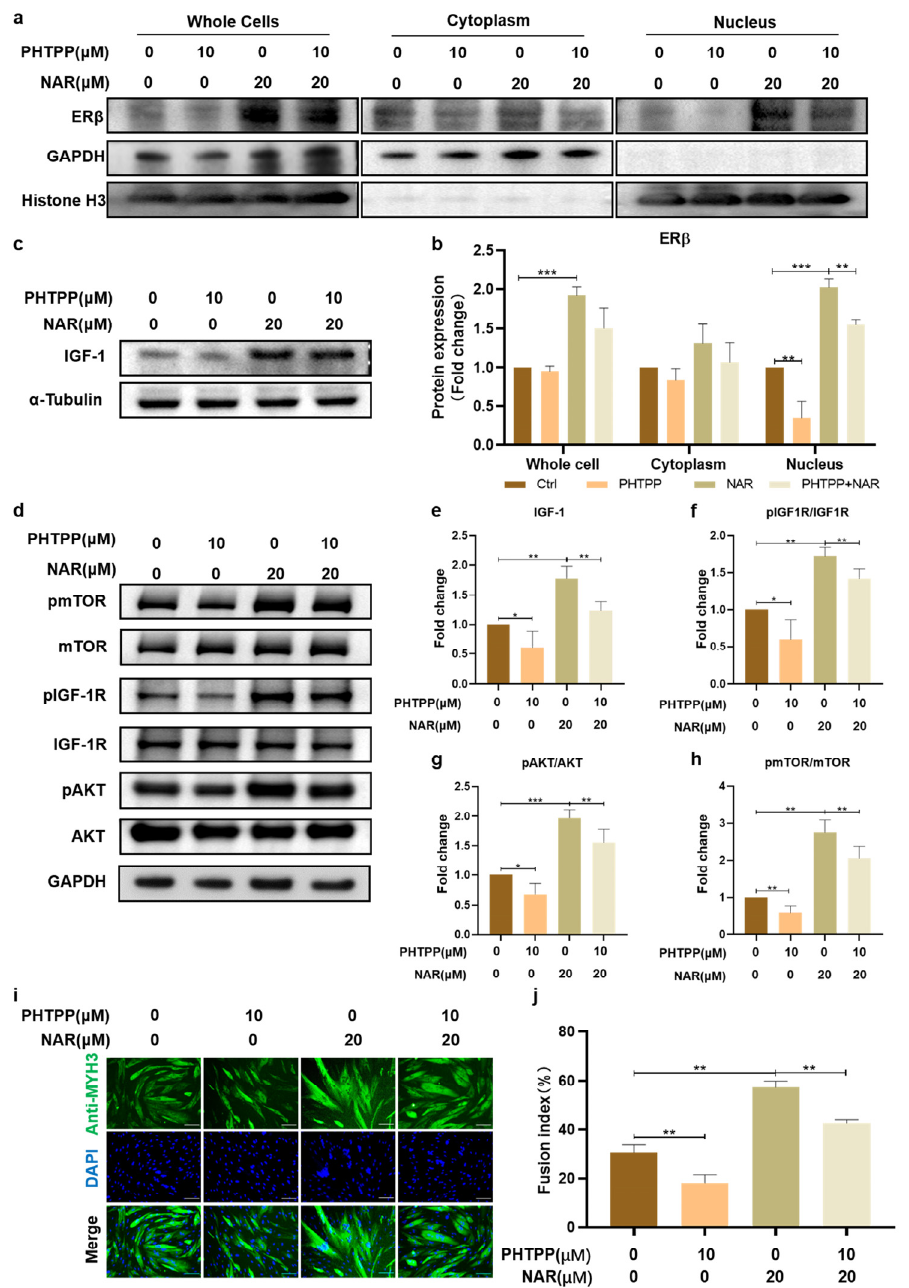
Figure 5. Inhibition of ER β impaired the effect of NAR on IGF-1 signaling and myogenesis. ( a ) Representative blots of ER β , GAPDH, and histone H3 in whole cells, cytoplasm, and nucleus. Protein was extracted from P6 PSCs after three days of differentiation with or without supplementation of NAR (20 µM) and/or PHTPP (10 µM). ( b ) Quantification of ER β ratios according to ( a ). The bar chart presents quantification of blot band intensity, normalized to GAPDH or histone H3 levels, and presented as fold change relative to the sample without treatment of NAR or PHTPP ( n = 3 biological replicates). ( c , d ) Representative blots of IGF-1, IGF-1R, pIGF-1R, mTOR, pmTOR, AKT, pAKT, GAPDH, and α -tubulin in differentiating P6 PSCs after three days of induction with or without supplementation of NAR (20 µM) and/or PHTPP (10 µM). ( e ) Quantification of IGF-1 expression according to ( c ). The bar chart presents the quantification of blot band intensity, normalized to α -tubulin levels, and presented as fold change relative to the sample without treatment of NAR or PHTPP ( n = 3 biological replicates). ( f – h ) Quantification of pmTOR/mTOR, pIGF1-R/IGF-1R, and pAKT/AKT ratios according to ( d ). The bar chart presents the quantification of blot band intensity, normalized to GAPDH levels, and presented as fold change relative to the sample without treatment